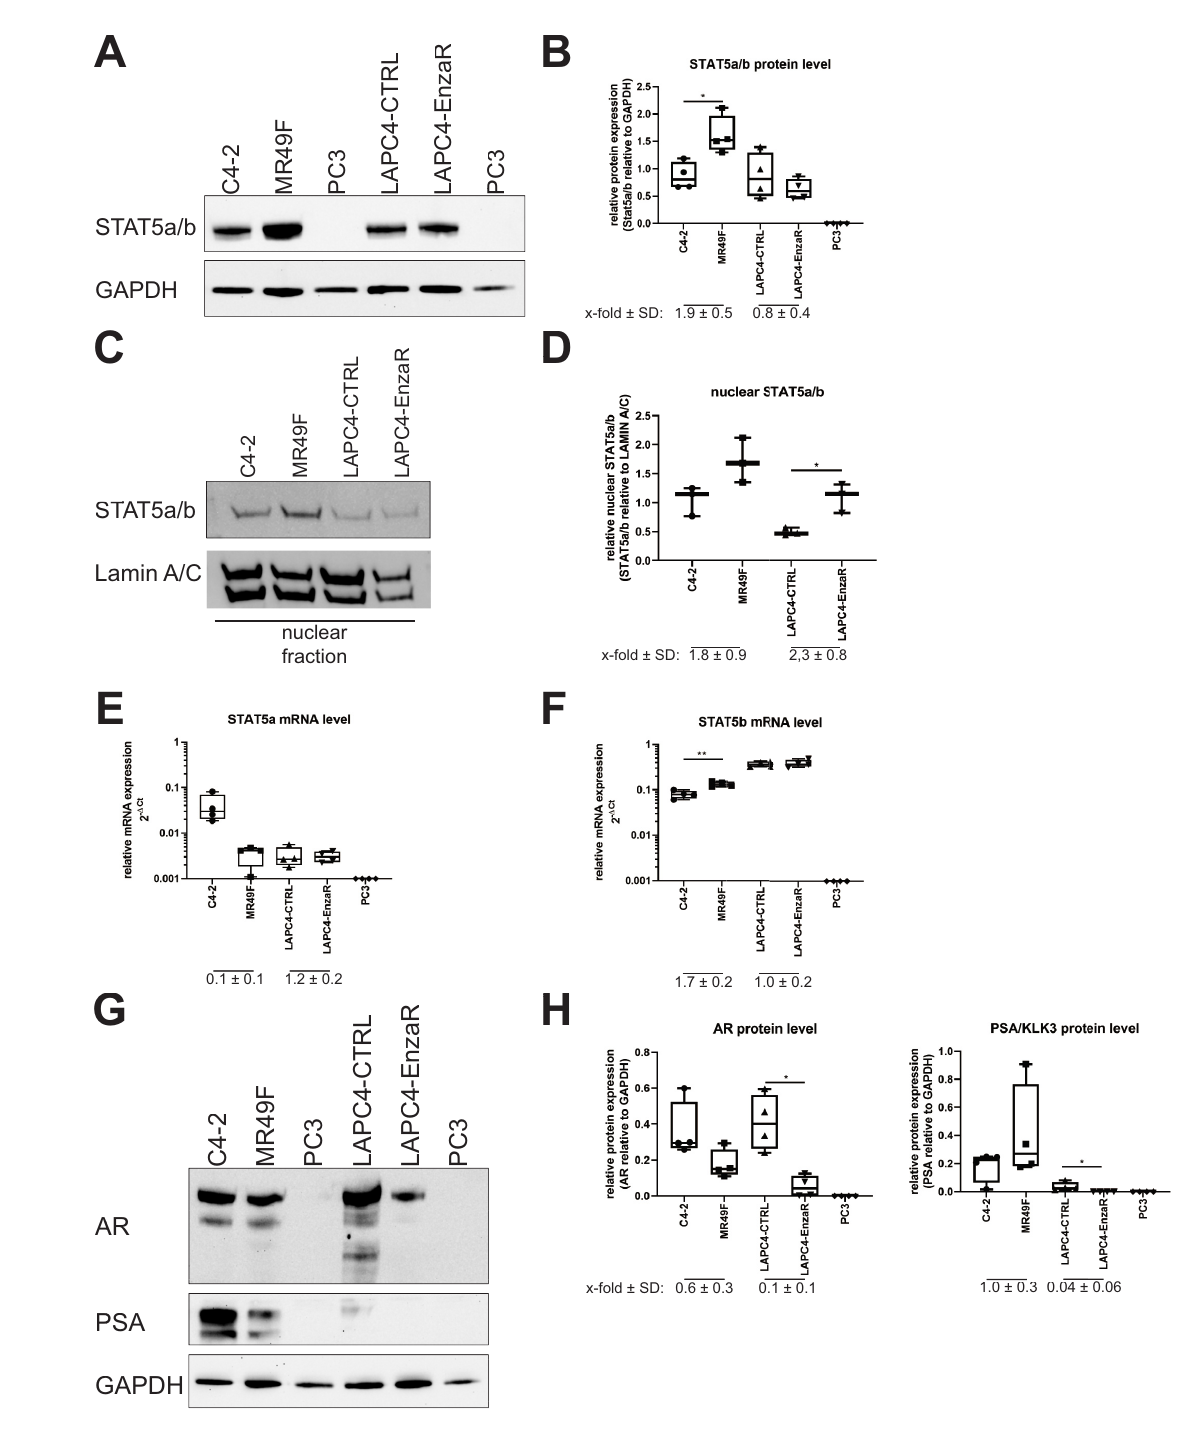
Fig 2. STAT5 expression in enzalutamide-resistant cell models derived from LNCaP and LAPC4. (A) Representative western blot of STAT5a/b and GAPDH expression in C4-2, MR49F, LAPC4-CTRL, LAPC4-EnzaR and PC3 cells. PC3 cells were used as a negative control for STAT5 and AR expression. (B) Densitometric analysis of STAT5a/b protein expression levels relative to GAPDH. Data is shown as box plot with whiskers (min to max) of at least three independent western blot experiments. (C) Representative western blot of nuclear STAT5a/b and Lamin A/C protein in C4-2, MR49F, LAPC4-CTRL, LAPC4-EnzaR cells. (D) Densitometric analysis of STAT5a/b protein expression levels relative to Lamin A/C. Data